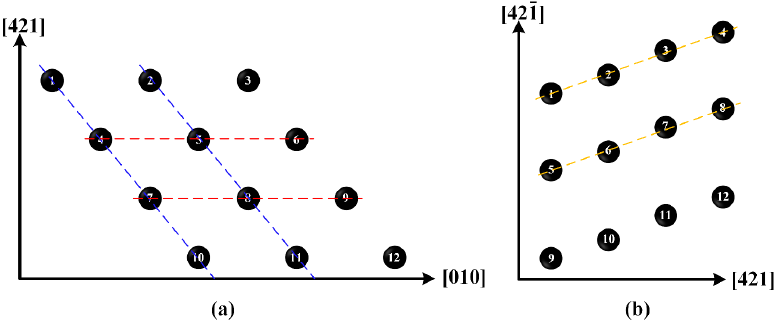
Figure 8. Arrangement of calcium carbonate molecules on ( a ) top plane and ( b ) side plane.